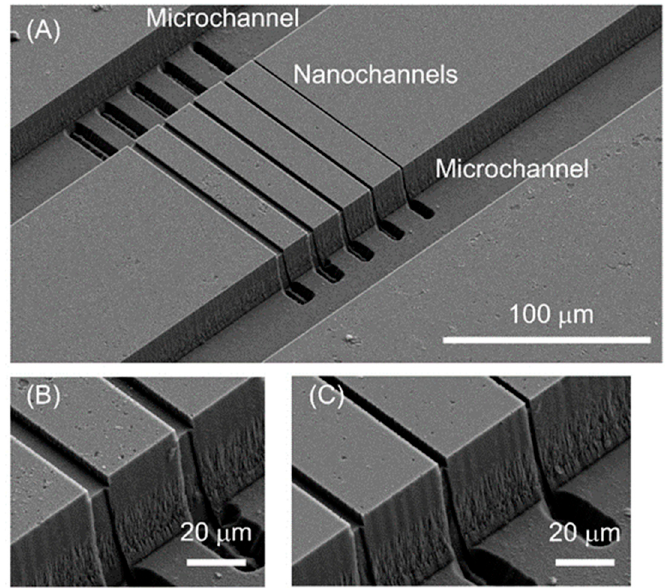
Figure 6. SEM images of microchannels formed on a substrate already having nanochannels. ( A ) Microchannels (width: 51 µ m and depth: 23 µ m) connected to nanochannels (widths: 1100, 2100, 3100, 4100 and 5100 nm, depth: 2200 nm). ( B ) Enlarged image showing the connections of the 4100 and 5100 nm channels. ( C ) Enlarged image showing the connections of the 1100, 2100 and 3100 nm channels.